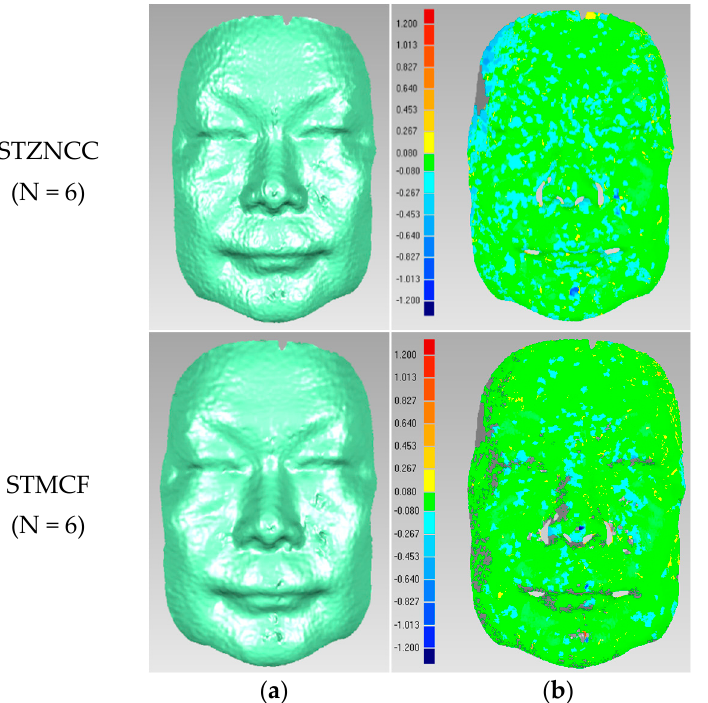
Figure 9. ( a ) 3D reconstruction result of the plastic human face (N = 6); ( b ) Corresponding error distribution map.